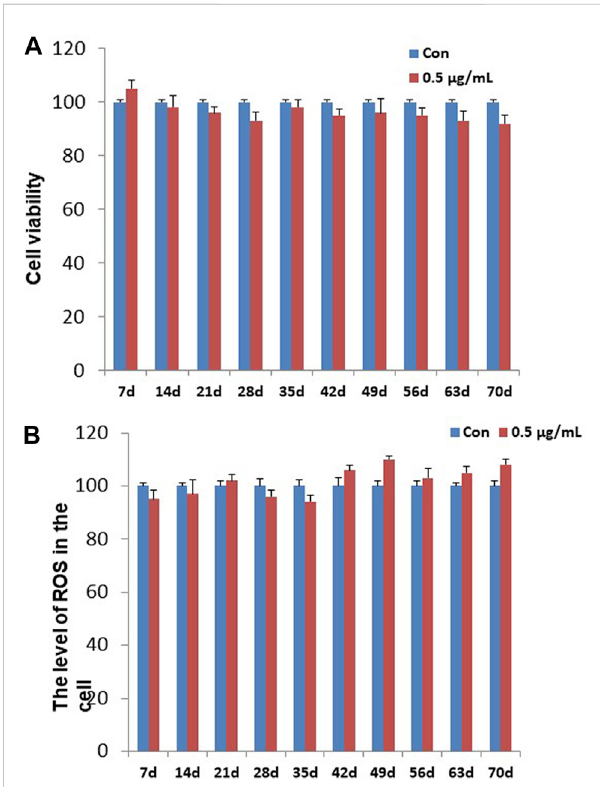
FIGURE 1 Effects of GO-AgNPs on the proliferation and ROS level of caprine fetal fi broblast cells (CFFCs). CFFCs were exposed to 0 and 0.5 μ g/mL of GO-AgNPs for 70 days. (A) The percentage of CFFCs viability was then calculated relative to the control group (0 μ g/ mL). (B) Total reactive oxygen species (ROS) generation in GO-AgNP- treated cells. Caprine fetal fi bro-blast cells (CFFCs) were checked for ROS every week. The percentage of ROS generation relative to the untreated control group (0 μ g/mL). Values are presented as the mean ± SD of four independent